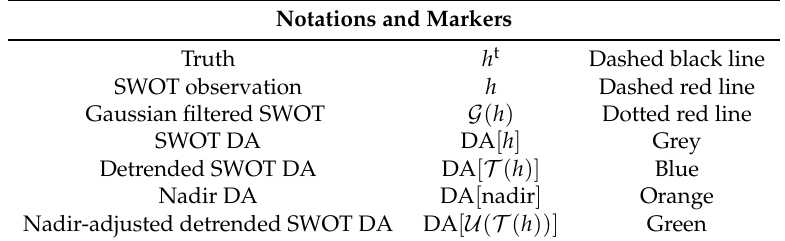
Table 2. A glossary of the variable names and markers for the experimental